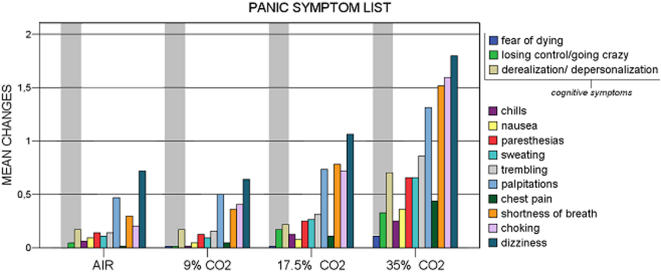
DSM panic symptoms intensity in healthy subjects taking four different doses of CO2.